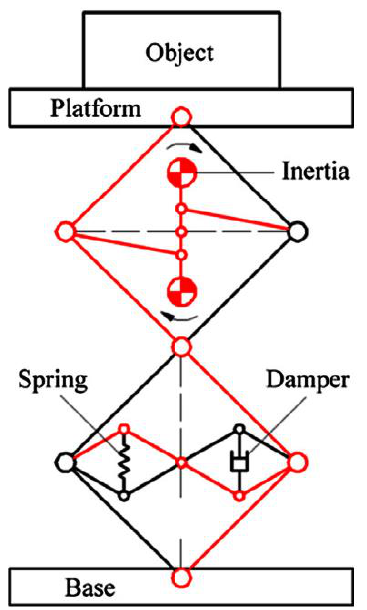
Figure 17. Structure diagram of bionic anti-vibration device [71].